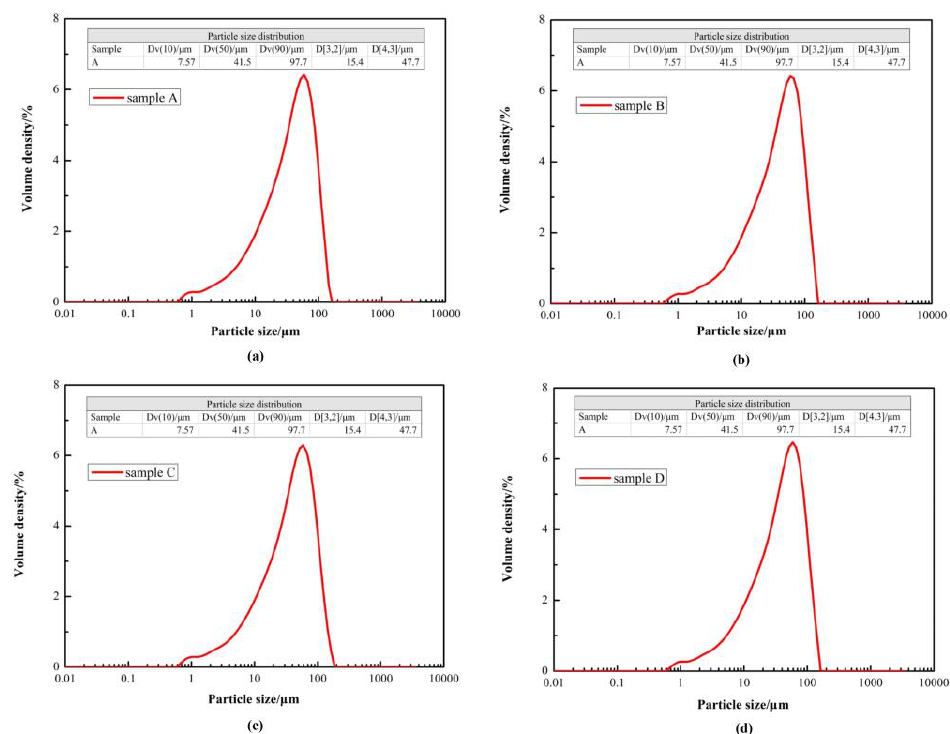
Figure 2. The particle size distribution curve of sample A, B, C and D. ( a ): Sample A, ( b ): Sample B, ( c ): Sample C, ( d ): Sample D.